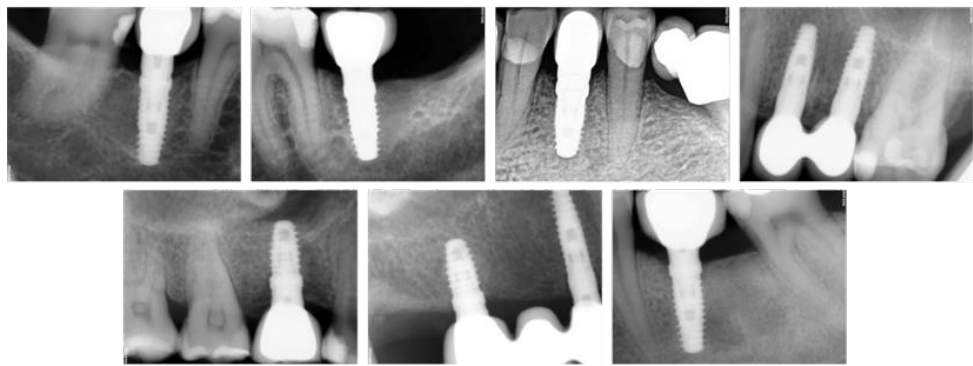
Figure 8. Radiographic evaluations of the implants at 7 months.